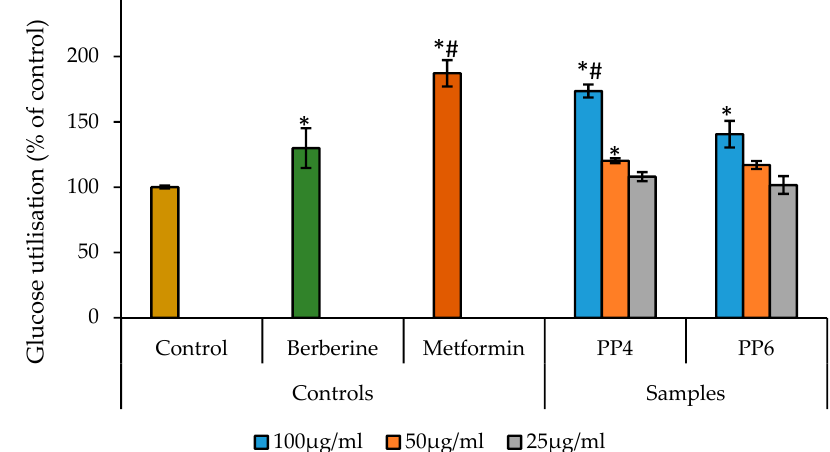
Figure 5. E ff ect of PP4 and PP6 isolated from L. tetragona extract on glucose uptake in HepG2 hepatocytes. The cells were treated with or without di ff erent concentrations of the samples for 48 h. Data expressed as mean ± SD (n = 5). A significant increase compared to the control is indicated by “*” ( p < 0.05) whereas “#” indicates a significant increase compared to berberine (10 µ g / mL) ( p < 0.05). No significant increase was observed in the samples compared to metformin (0.1 µ g / mL).